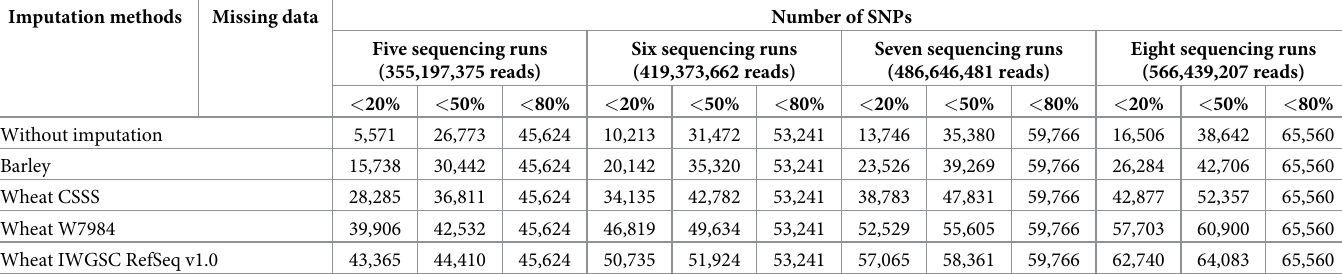
Table 5. Numbers of SNPs called after five (3 runs of the library 1 and 2 runs of the library 2), six (4 runs of the library 1 and 2 runs of the library 2), seven (5 runs of the library 1 and 2 runs of the library 2) and eight (6 runs of the library 1 and 2 runs of the library 2) sequencing runs of the two GBS libraries with and without imputation using barley genome and Chinese Spring survey sequence (CSSS) and W7984 assembly and Wheat IWGSC RefSeq v1.0